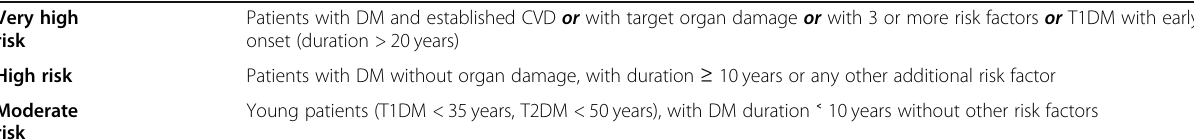
Table 2 Risk stratification for DM patients Very high Patients with DM and established CVD or with target organ damage or with 3 or more risk factors or T1DM with early risk onset (duration > 20 years) High risk Patients with DM without organ damage, with duration ≥ 10 years or any other additional risk factor Moderate risk